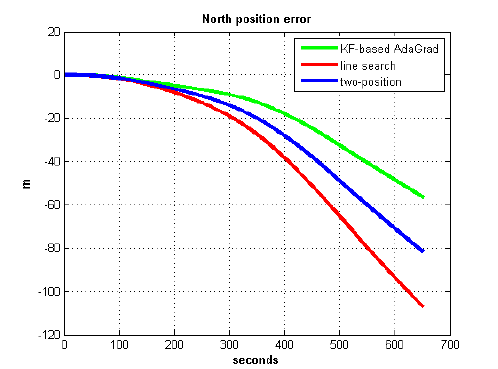
Figure 20. North position error in test